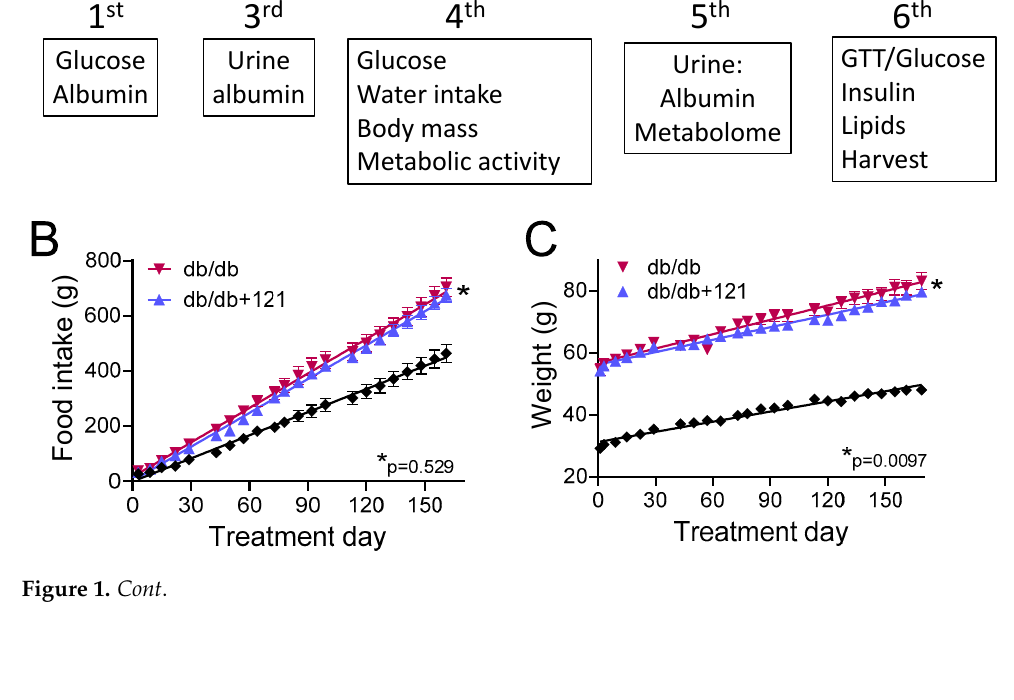
Figure 1. Experimental timeline and nutritional parameters, body mass, locomotor activity, and metabolic activity of db/db mice fed a control diet or a diet containing the AD drug candidate CMS121 for 6 months. Beginning at the 5th week after birth, mice were either kept on the control diet (db/db) or on a diet containing CMS121 (db/db + 121) ad libitum (See M&M for details). ( A ) Timeline and end points analyzed. Wildtype (WT) mouse data are presented as a reference. Cumu- lative food intake ( B ) and body weight ( C ). Food intake per animal was based on the food